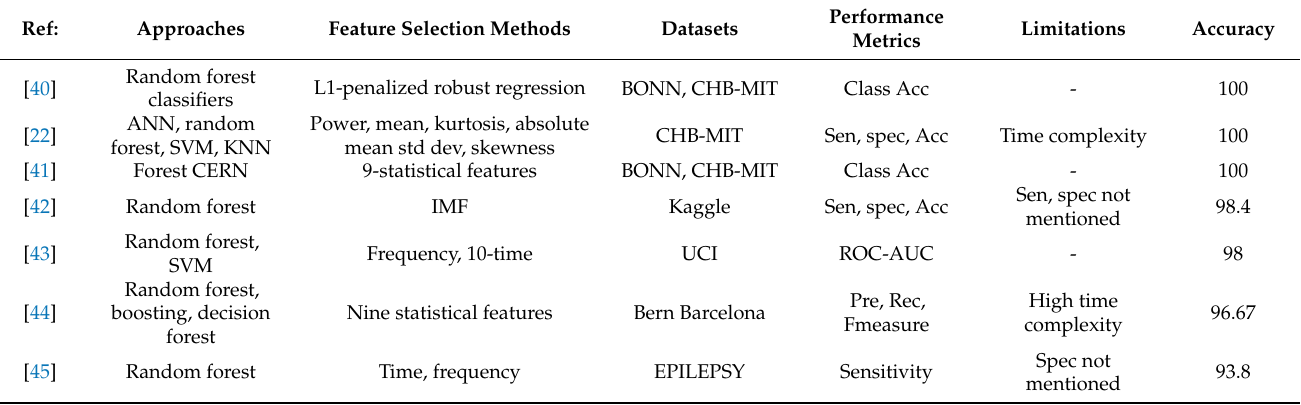
Table 5. A review on RF approach for seizure